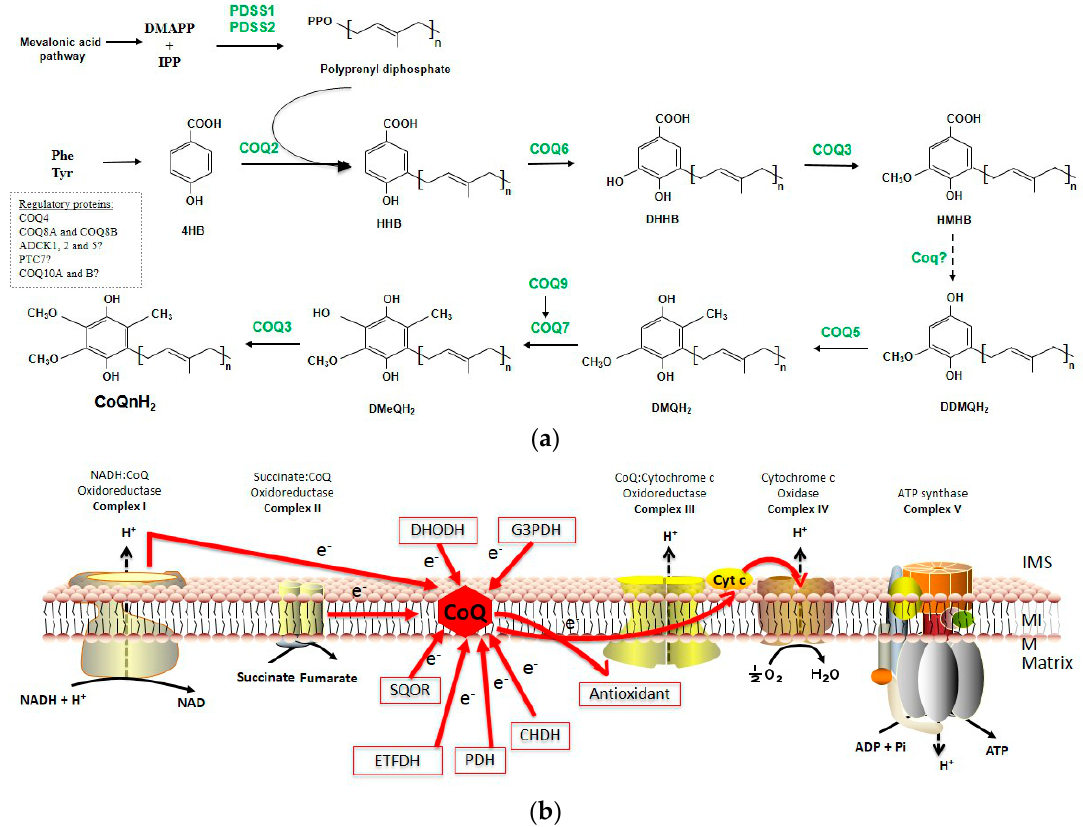
Figure 1. The coenzyme Q (CoQ) biosynthesis pathway and functions of CoQ. ( a ) Schematic model of mammalian cells CoQ biosynthesis pathway: 4-hydroxybenzoic acid (4HB) is the ring precursor, dimethylally pyrophosphate (DMAPP) and isopentenyl pyrophosphate (IPP) are precursors to form polyprenyl diphosphate via prenyldiphosphate synthase subunit (PDSS)1/PDSS2. CoQ2 attaches the polyisoprenyl tail to 4HB to form 3-hexaprenyl-4HB (HHB). The next intermediates are: 3-hexaprenyl- 4,5-dihydroxybenzoic acid (DHHB), 3-hexaprenyl-4-hydroxy-5-methoxybenzoic acid (HMHB), 2- hexaprenyl-6-methoxy-1,4-benzenediol(DDMQH2), 2-hexaprenyl-3-methyl-6-methoxy-1,4-benzenediol (DMQH2), and 2-hexaprenyl-3-methyl-6-methoxy-1,4,5-benzenetriol (DMeQH2) to ultimately produce reduced coenzyme Q (CoQnH2). ( b ) CoQ functions in the mitochondria. CoQ accepts electrons from complex I and complex II, sulfide quinone oxidoreductase (SQOR), proline dehydrogenase 1 (PDH), coline dehydrogenase (CHDH), mitochondrial glycerol-3-phosphate dehydrogenase (G3PDH), dihydroorotate dehydrogenase (DHOH) and electron transport flavoprotein dehydrogenase